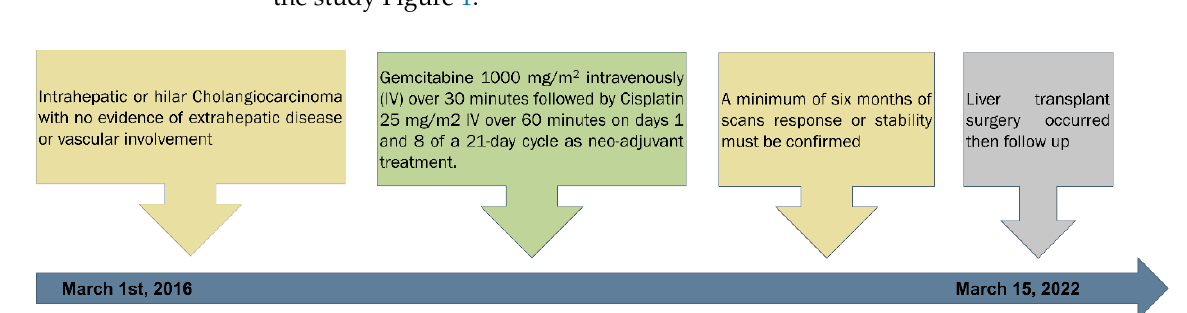
Figure 1. Schema of the treatment timeline of gemcitabine and cisplatin as neo-adjuvant for cholan- giocarcinoma patients prior to liver transplantation.